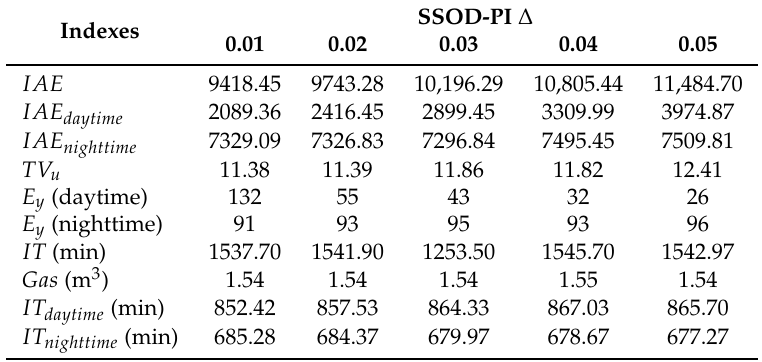
Table 2. Performance Symmetric-Send-On-Delta-Proportional-Integral (SSOD-PI)